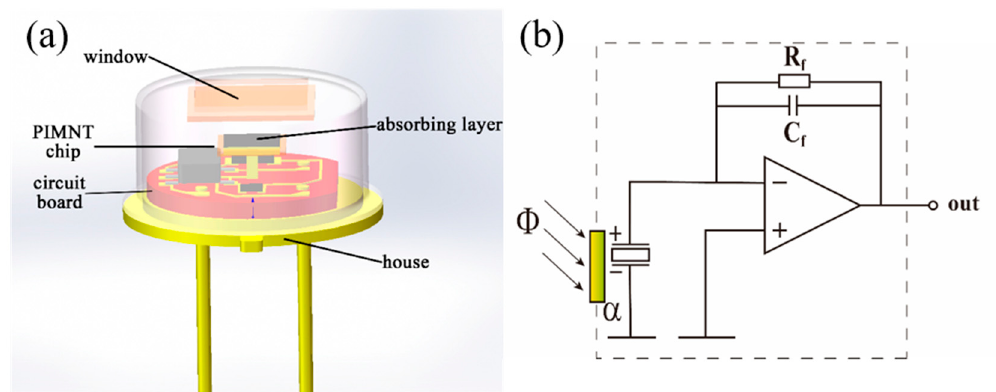
Figure 8. ( a ) Basic structure and ( b ) equivalent circuit (current mode) of the Mn:PIMNT pyroelectric infrared detectors. Table 4. Comparison of specific detectivity ( D* ) of the Mn:PIMNT pyroelectric infrared detectors and some other pyroelectric detectors (modulation frequency of 10 Hz, measured distance of 10 cm, measured bandwidth of 1 Hz, room temperature).